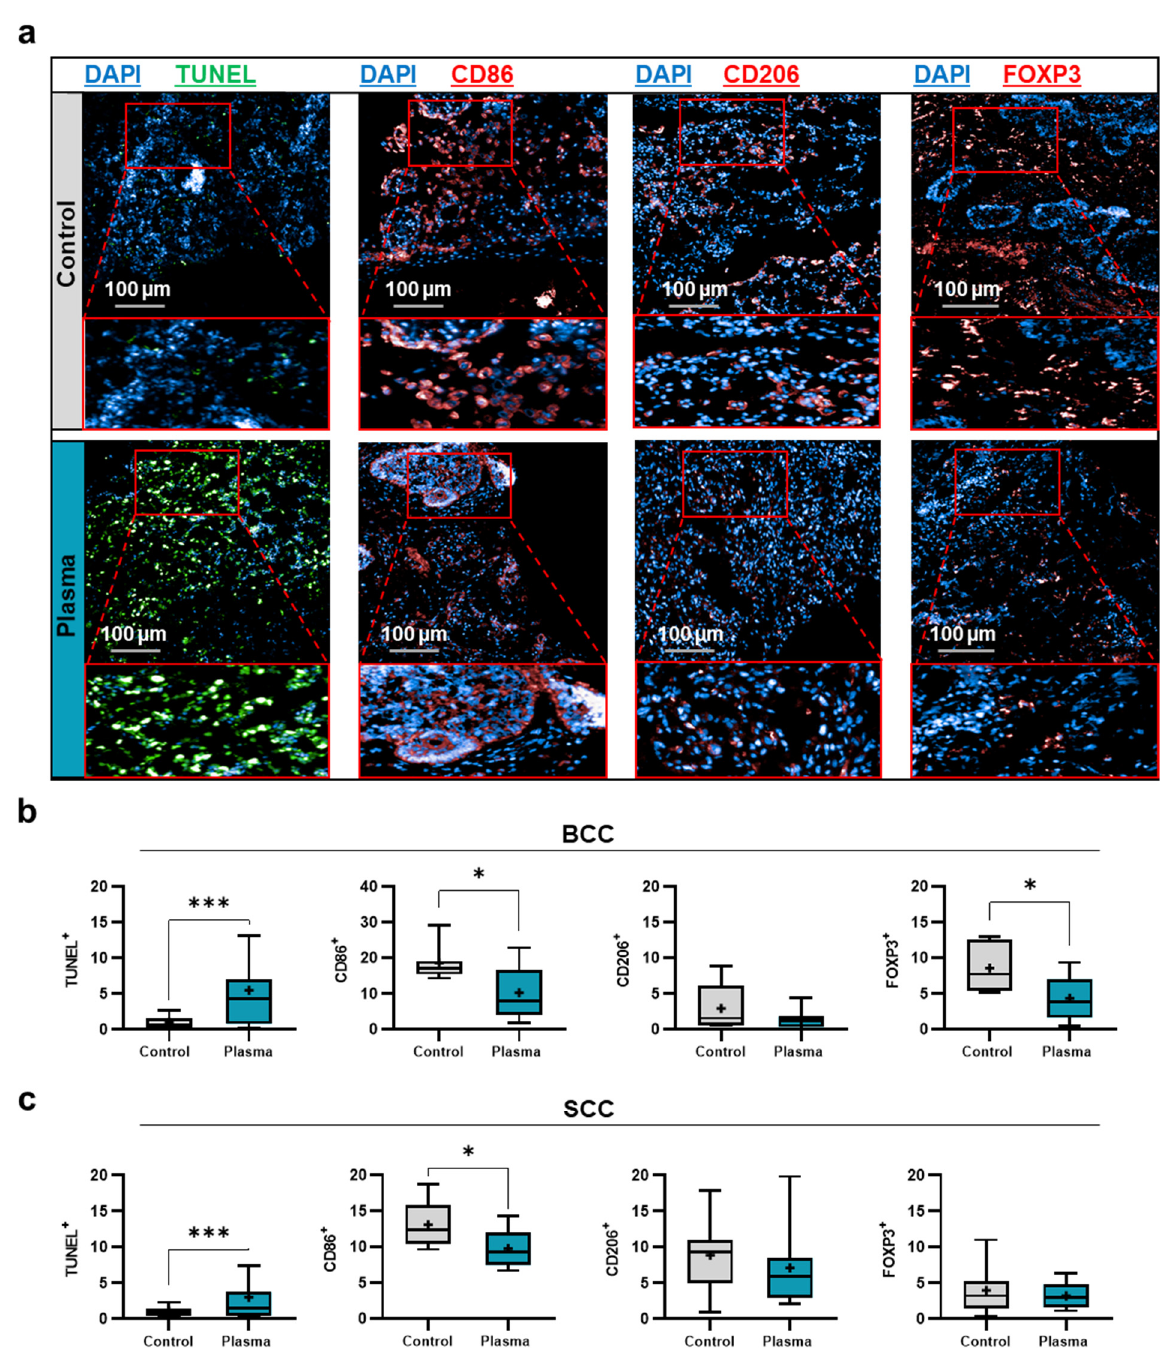
Figure 3. Immunofluorescence analysis: ( a ) representative immunofluorescence images of DAPI, TUNEL, CD86, CD206, and FOXP3 staining in gas plasma and argon gas (control)-treated BCC tissues; ( b ) quantitative imaging data for all markers in BCC samples; ( c ) quantitative imaging data for all markers in SCC samples. Data show boxplots from 6–8 patients, and statistical analysis was performed using t -test with p < 0.05 (*) and p < 0.001 (***). Scale bars are 100 µm.